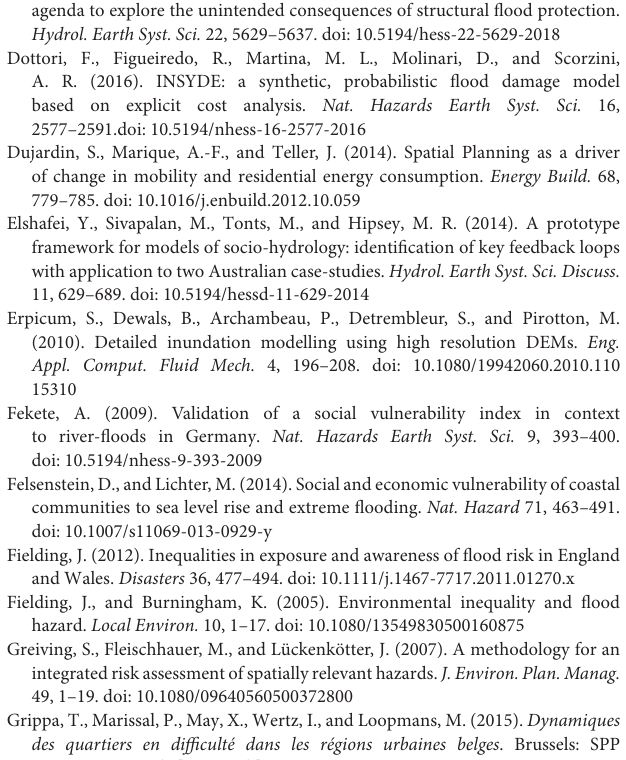
of hazard (low to high, medium to high, or high only); and (B) difference with respect to the household distribution in the whole